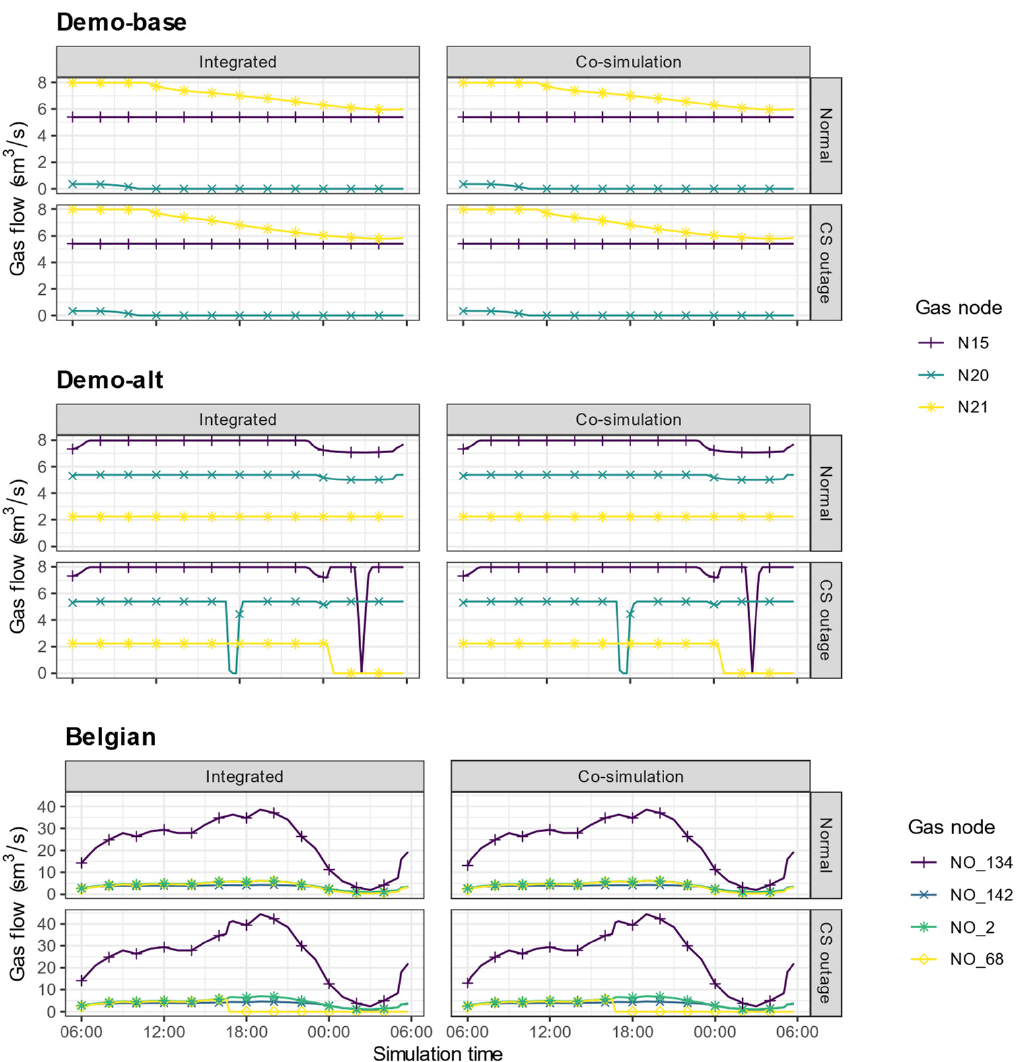
Figure 6. Gas flow (sm 3 /s) at gas delivery nodes that are coupled to the power system for each network and disruption scenario. The maximum MAPE across all scenarios is 0.0015%.